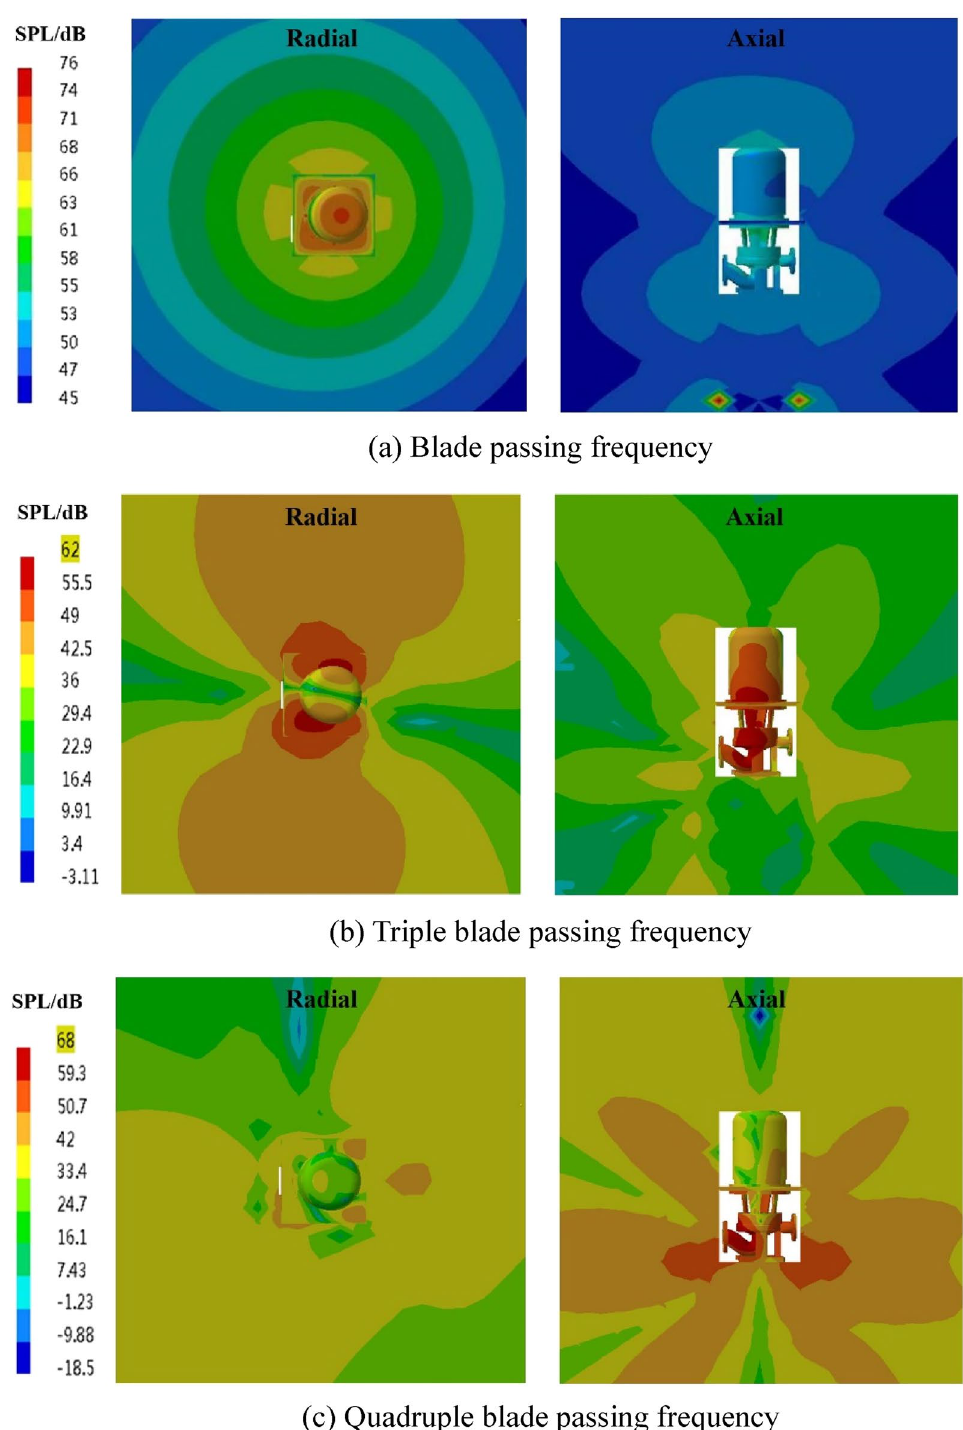
Figure 15. Distribution of outfield noise by fluid